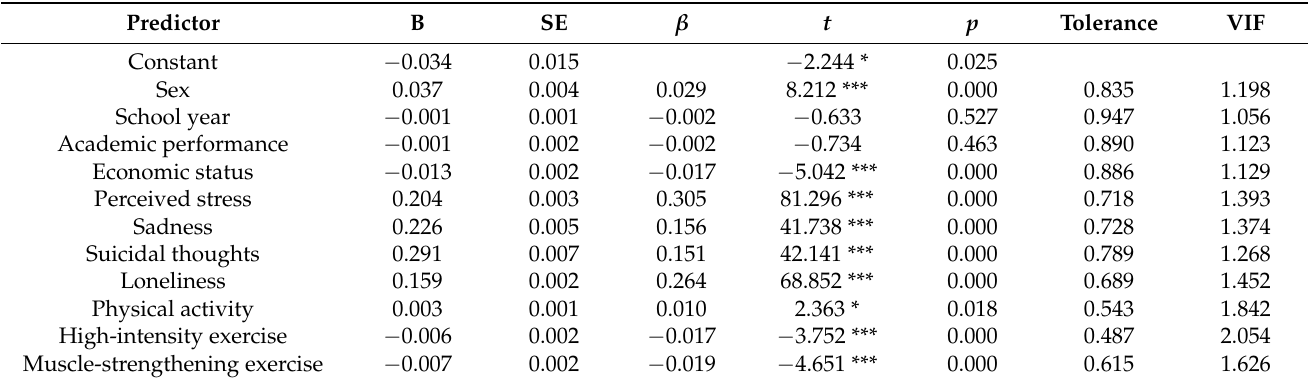
Table 6. Impact of major factors on